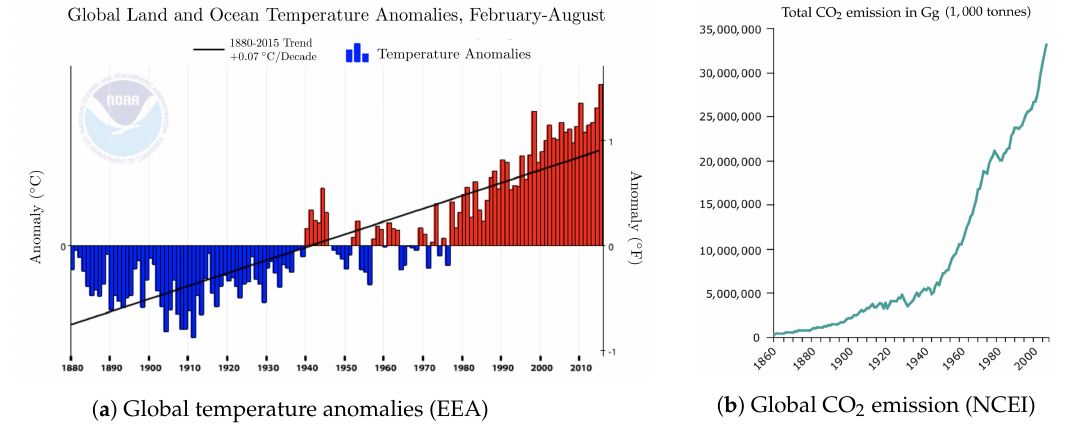
Figure 1. Climate